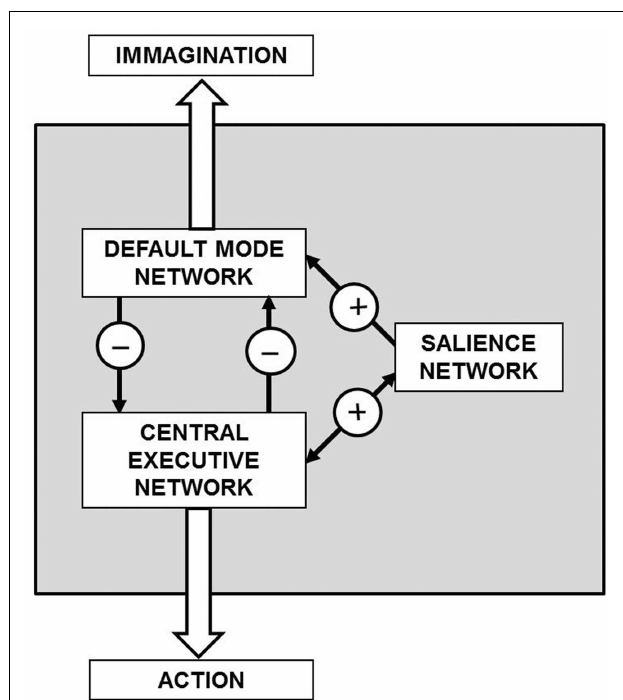
FIGURE 7 | General theoretical block diagram of the present hypothesis illustrating in a highly schematic way the cognitive control mechanisms that mediate concurrent activation and deactivation of three large-scale brain networks namely the default mode network, the central executive network, and the salience network during task performance or during imagination processes .The detailed morphofunctional descriptions of these networks and how their integrative actions take place are still largely